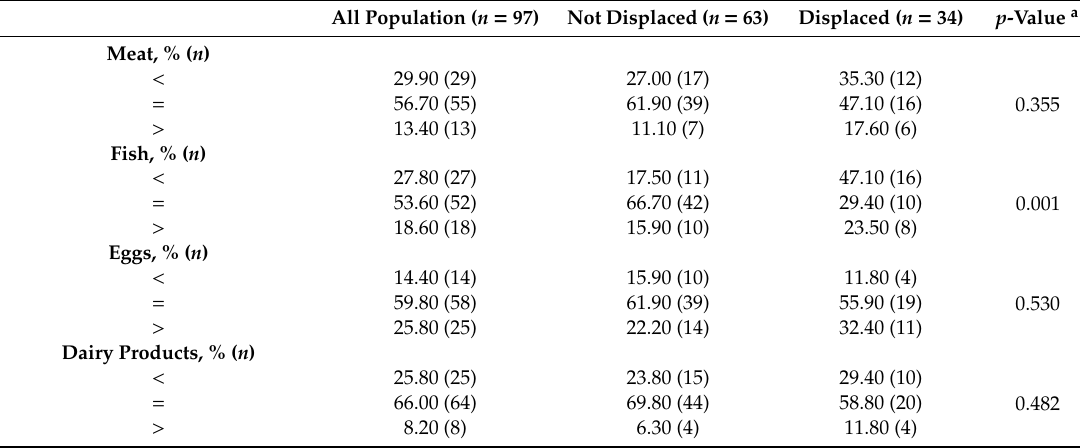
Table 3. Changes in the frequency of food intake, according to whether the university students are displaced from home or